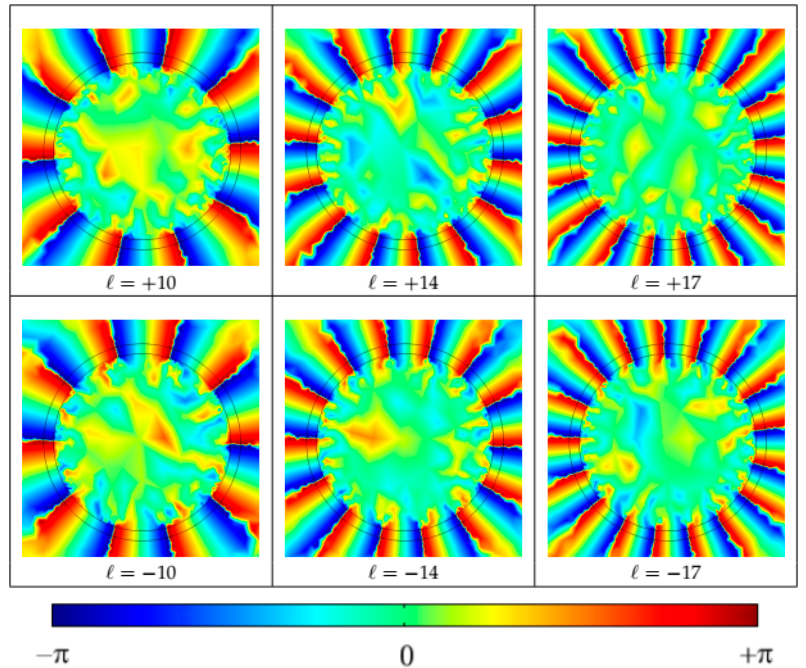
Figure 4. Phase distribution of OAM modes propagated in the simulated vortex-POF. Each SAM σ = ±1 produced two possible states for each OAM mode, yielding, in our case, up to 64 stable OAM states.